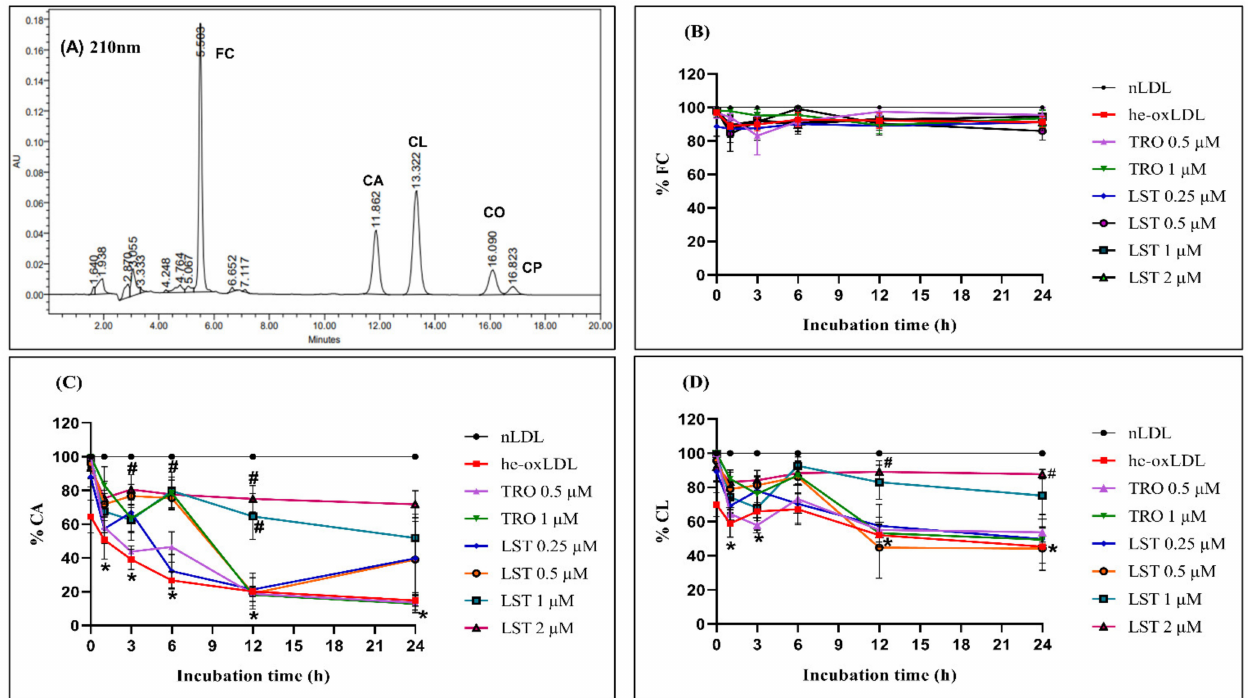
Figure 3. Effects of LST on lipid composition in hemin-induced LDL oxidation for 24 h. ( A ) Representative chromatogram of lipid composition detected at 210 nm; ( B ) % free cholesterol FC; ( C ) % cholesteryl arachidonate, CA; ( D ) % cholesteryl linoleate, CL; data were presented as mean ± SEMs ( n = 4); * p < 0.05 vs . nLDL; # p < 0.05 vs . he-oxLDL. Corresponding to the decreasing of CA and CL, the oxidized lipids were produced. The oxidized lipid products in he-oxLDL were detectable from 6 h (Figure 4). Thus, LST reduced oxidized lipid products in a concentration-dependent manner, whereas Trolox could not reduce oxidized lipid